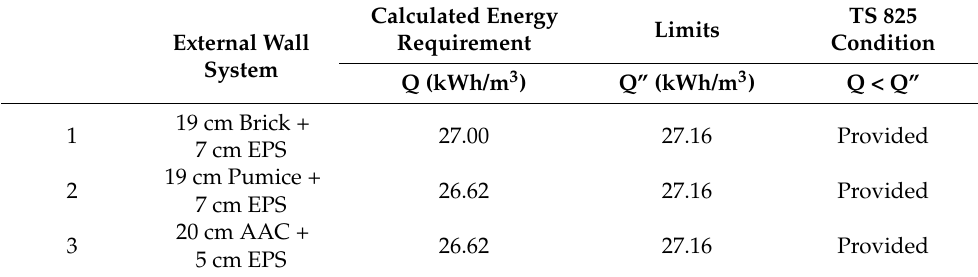
Table 7. The 3rd climate zone.